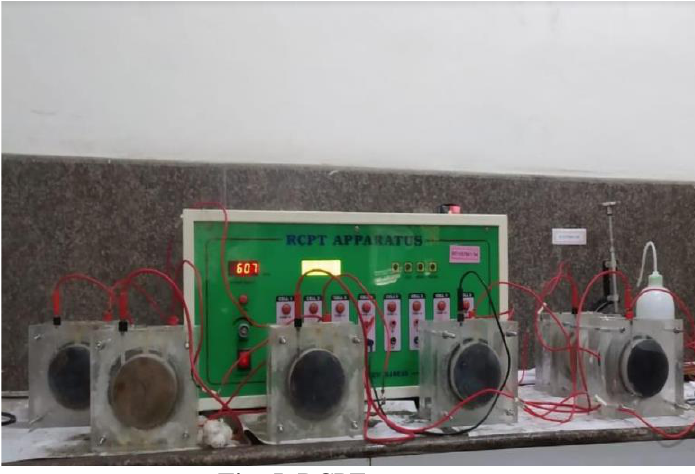
Fig. 5. RCPT test